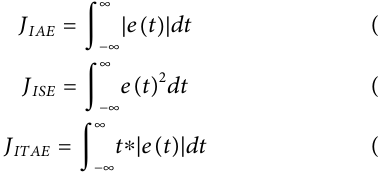
TABLE 3 | Summary of arti fi cial neural network design and architecture for forecasting solar photovoltaic power. Network